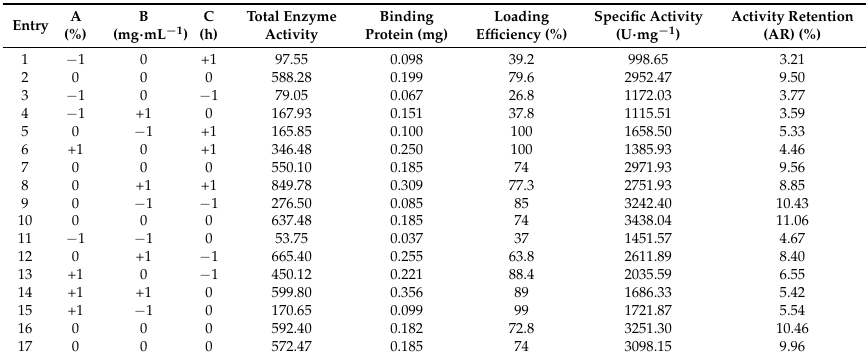
Table 3. Box–Behnken design of experiments for 17 trial